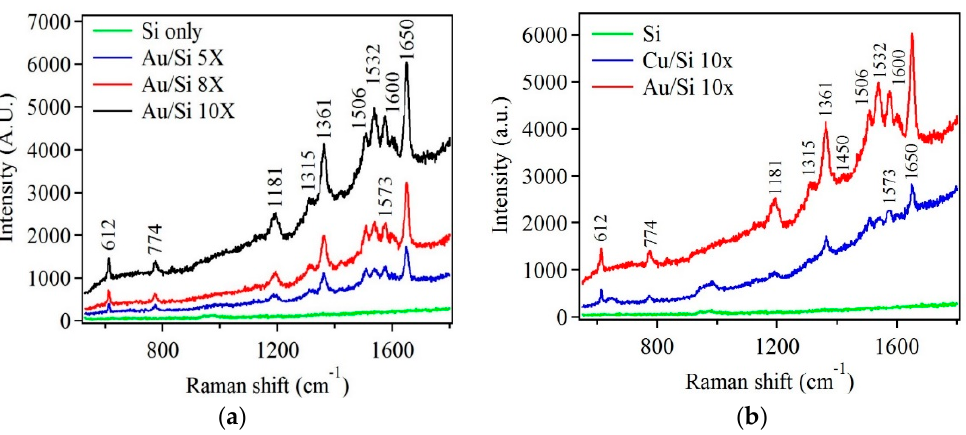
Figure 12. ( a ) Raman spectra of R6G on Si, and Au nanostructures samples after five, eight, and ten deposition cycles. ( b ) Raman spectra showing R6G modes for Au and Cu-based nanostructures. R6G concentration was 10 − 5